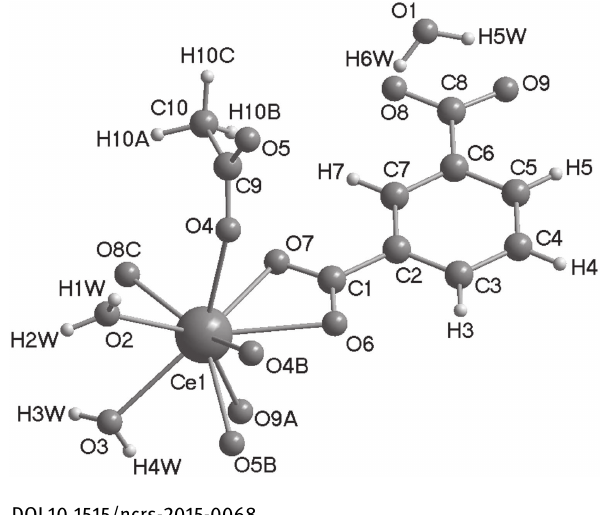
Table 1: Data collection and handling.